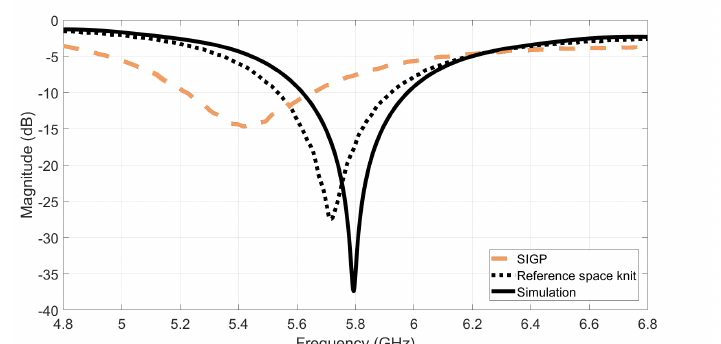
Figure 8. Simulated and measured S 11 of the textile microstrip patch antennas designed for the dielectric